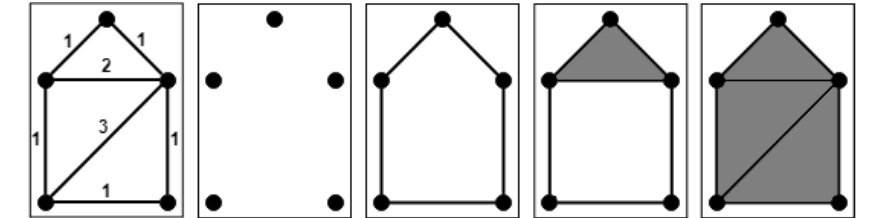
Figure 3. The weight rank clique filtration of the weighted network on the left.